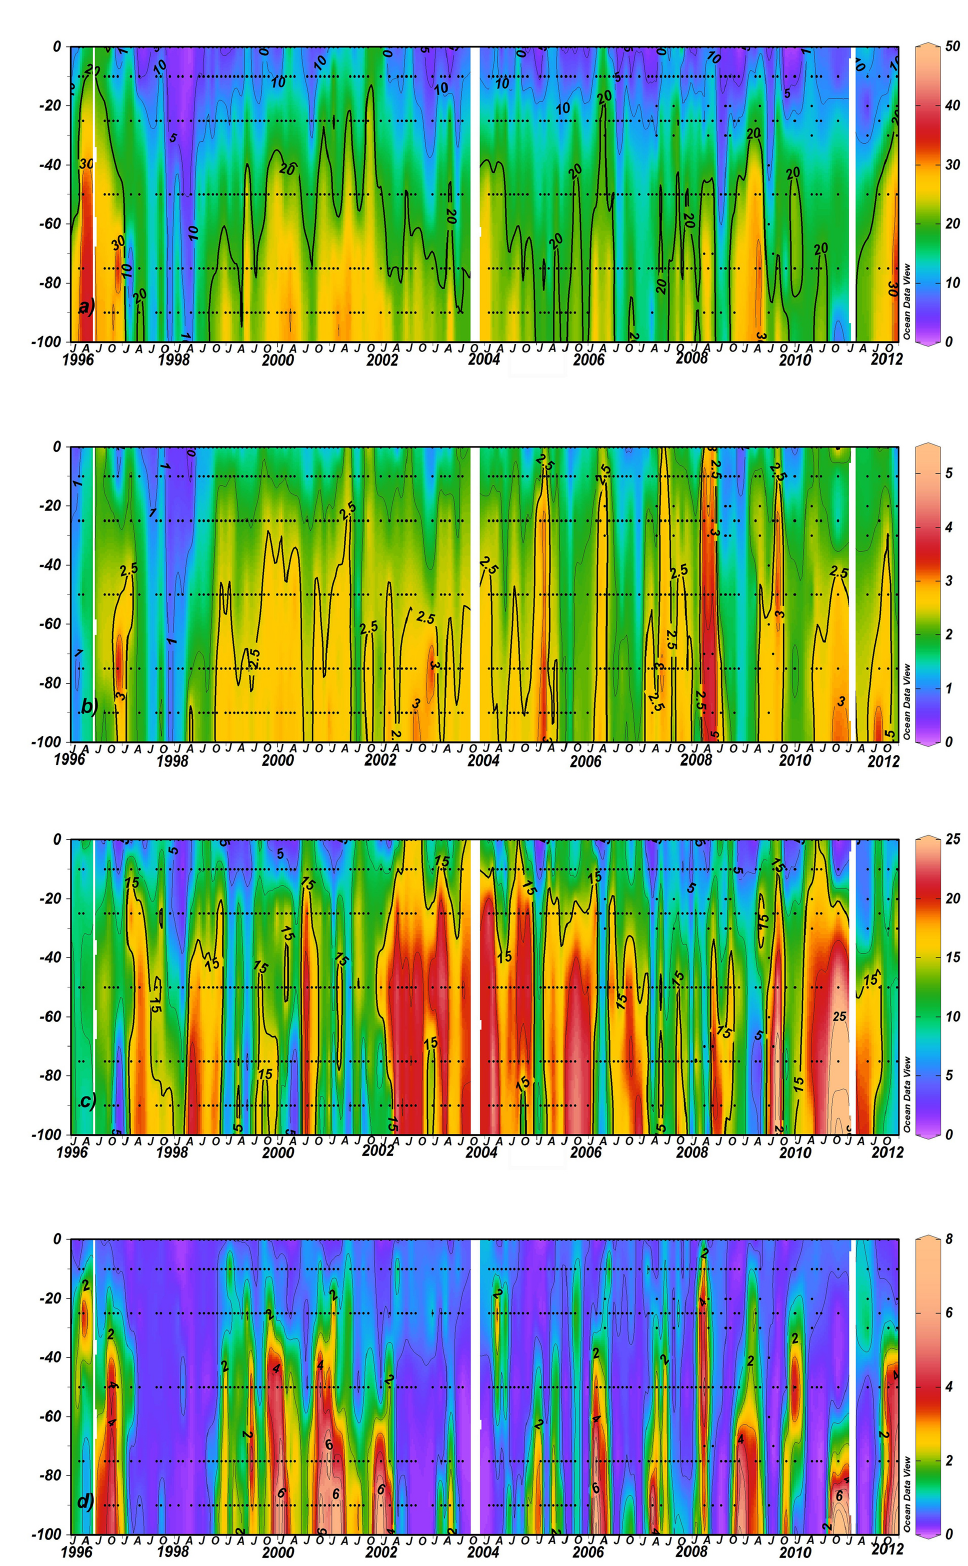
Figure 4. Time series of nitrate (a) , nitrite (b) , silicate (c) and phosphate (d) during 1996–2011. Units areµmolL − 1 . Black dots represent the data, and the figure presents a DIVA 2017 graphic interpolation only for the visualization of the